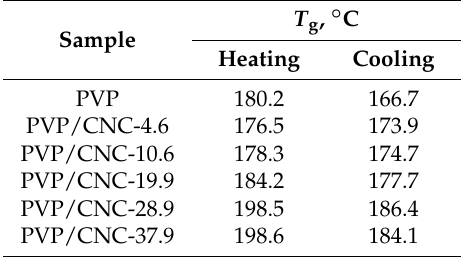
Table 2. Results of DSC analysis of the PVP/CNC composite films.